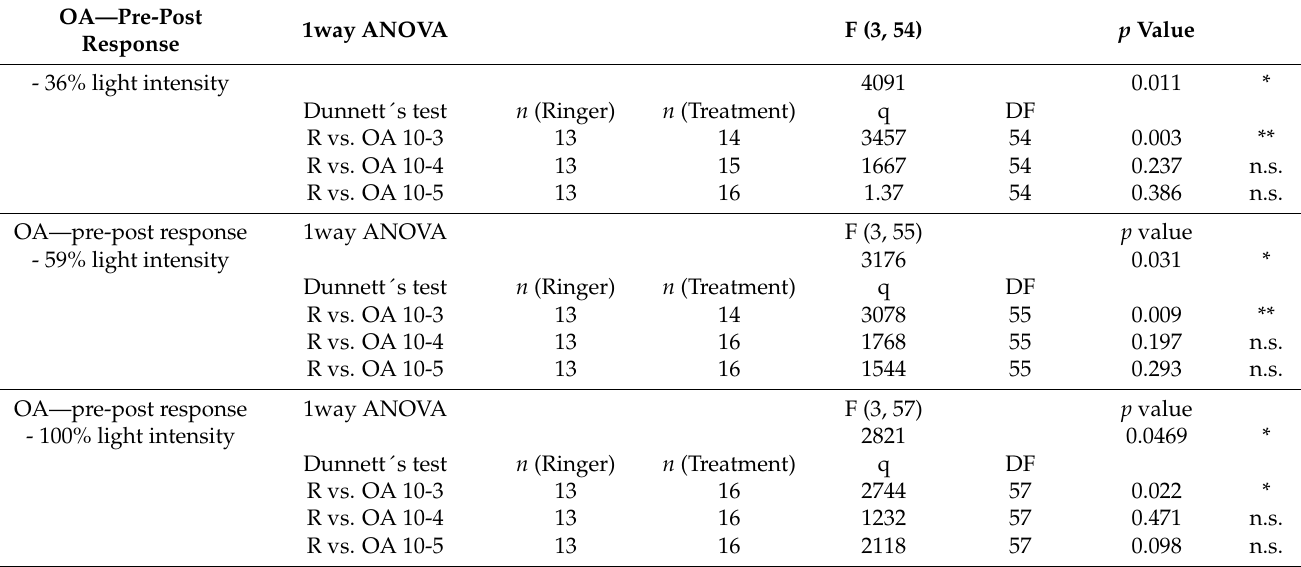
Table 2. Statistical comparison of the octopamine/tyramine (treatment) or Ringer (control) pre-post receptor response in the honeybee